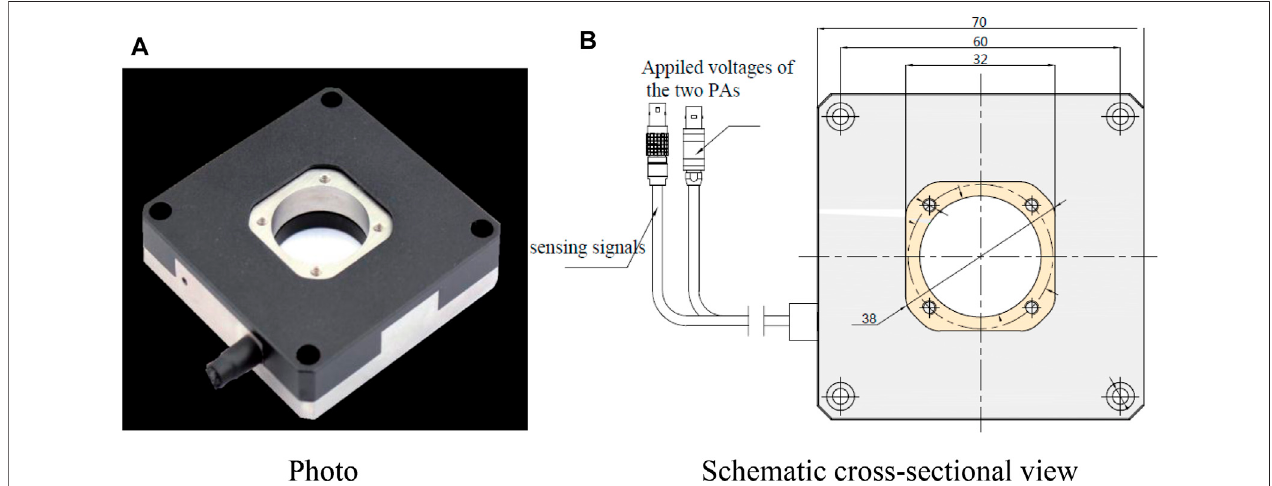
FIGURE 1 | Two-axis piezo-scanning mechanism: (A) photo and (B) Schematic cross-sectional view.